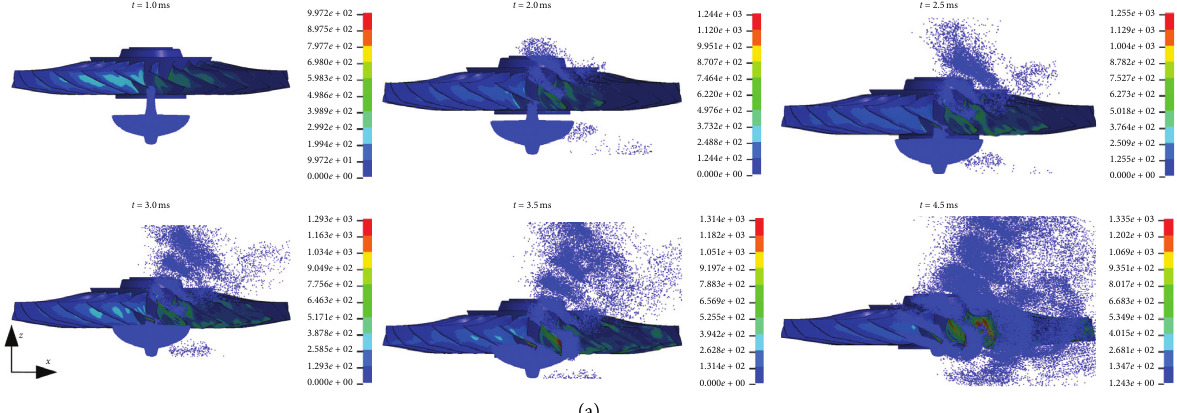
Figure 12: Bird deformation during the slicing action.